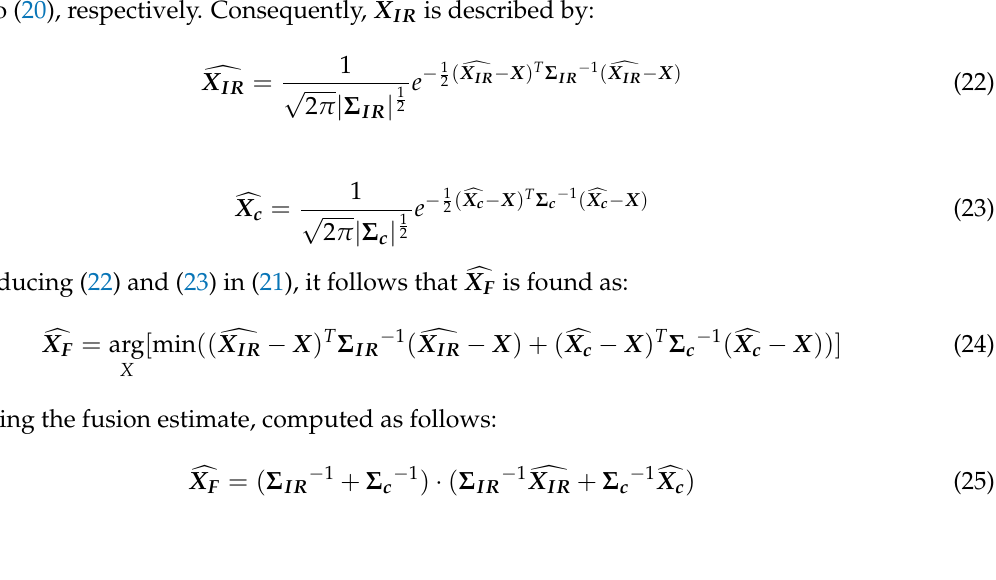
Figure 5. Camera errors ( x , y and elliptical deviations), green square represents camera projection on grid